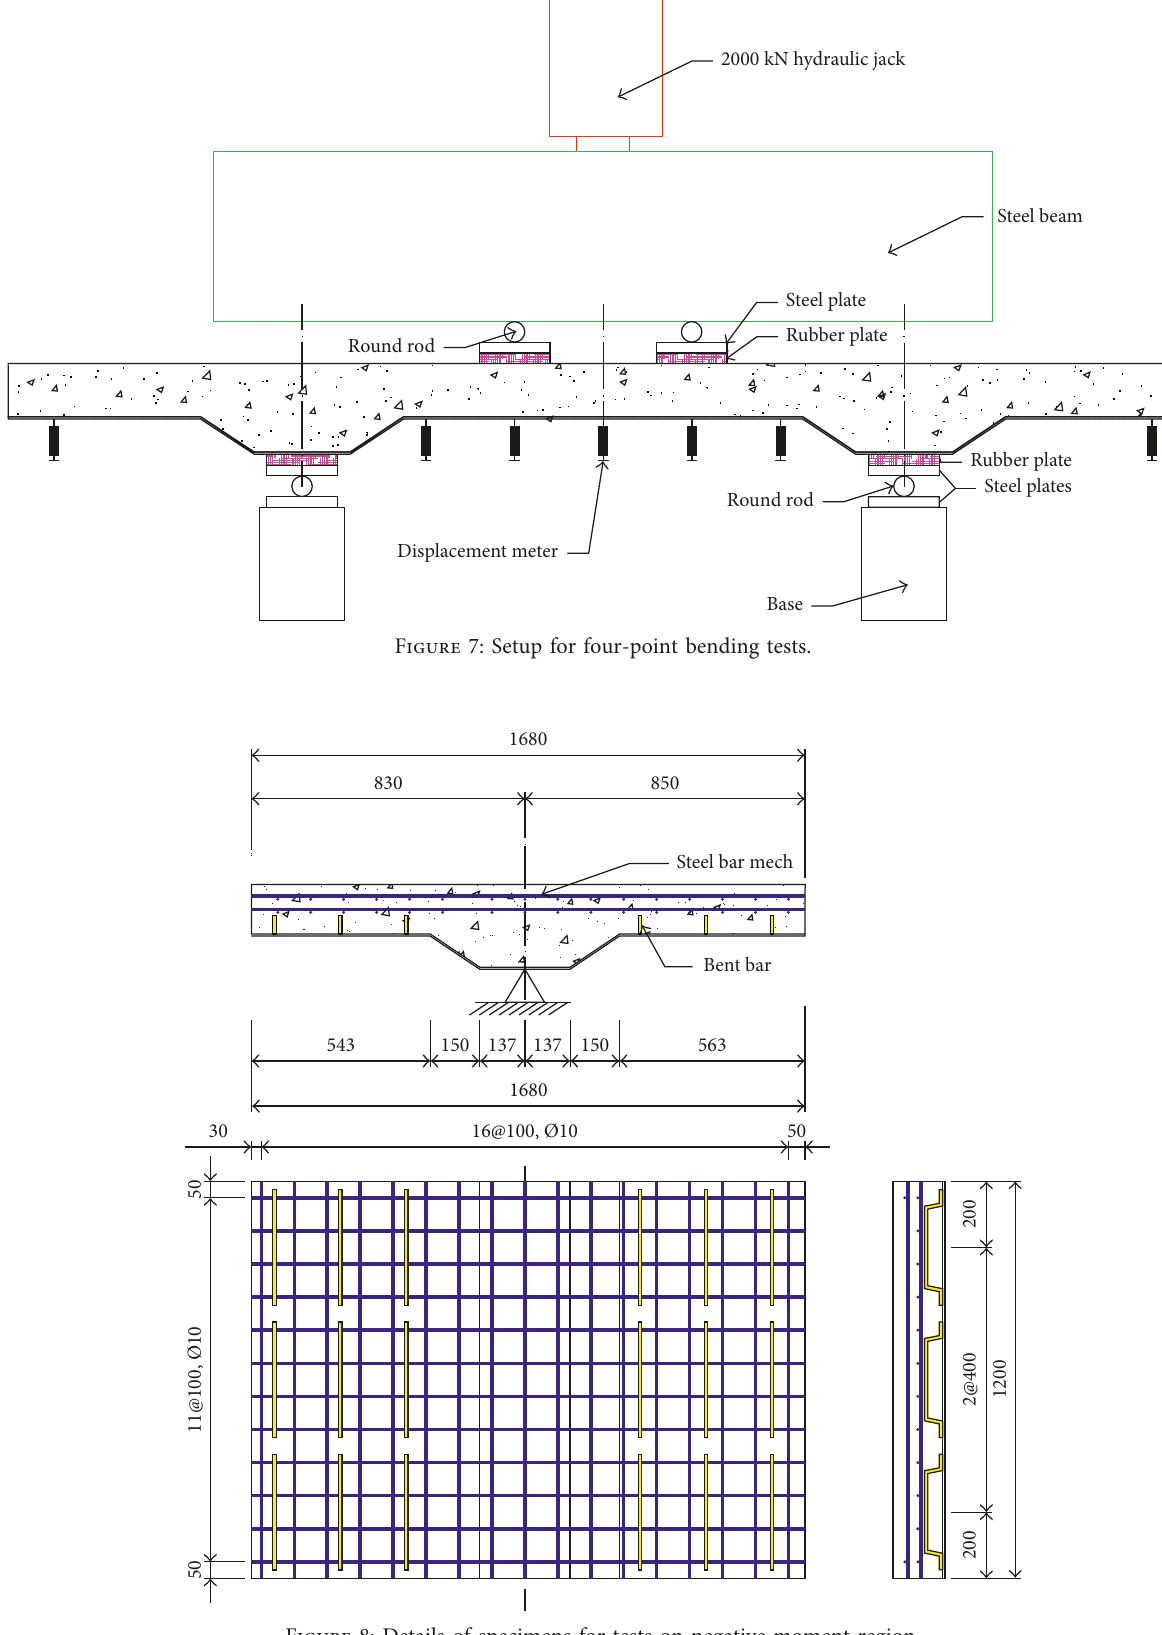
Figure 8: Details of specimens for tests on negative moment